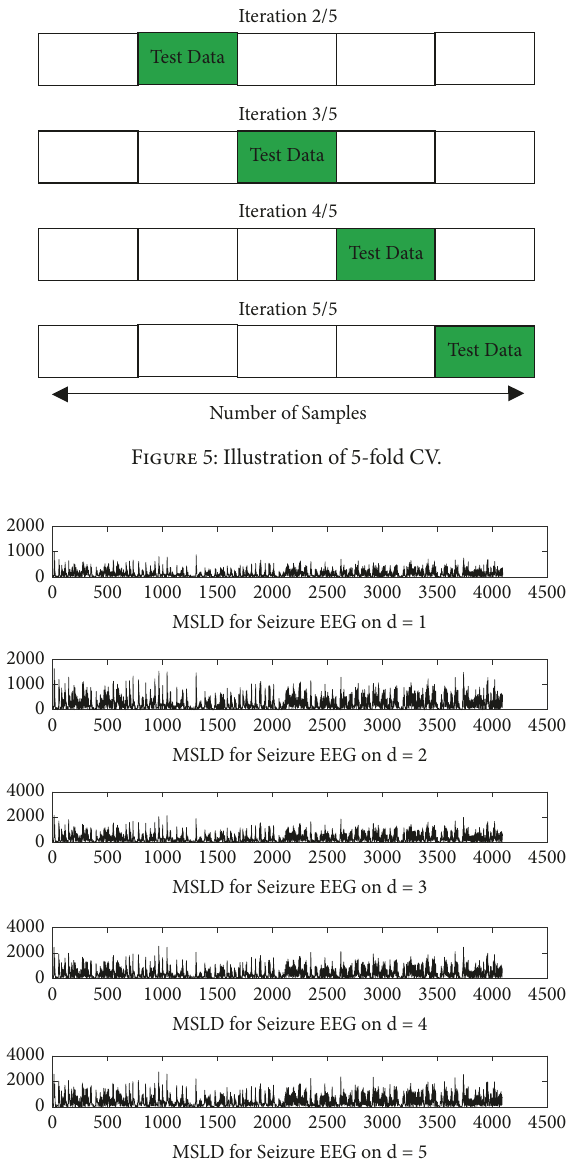
Figure 6: MSLD results of seizure EEG